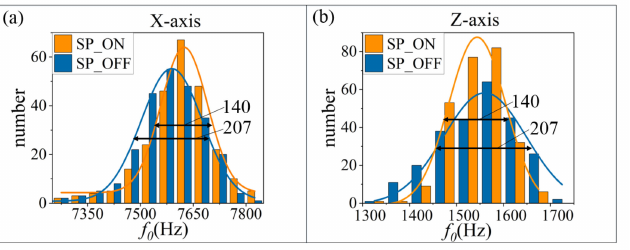
Figure 9. Statistical distribution of the resonant frequency. ( a , b ) are the Gaussian distribution of the resonant frequency along the X and Z axes,